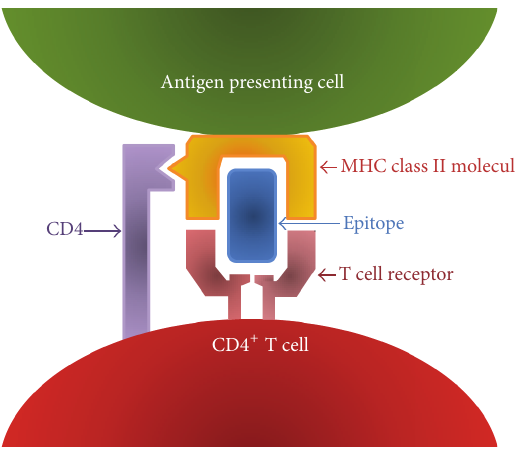
Figure 1: T cells recognize a complex of a peptide fragment and MHC (HLA in